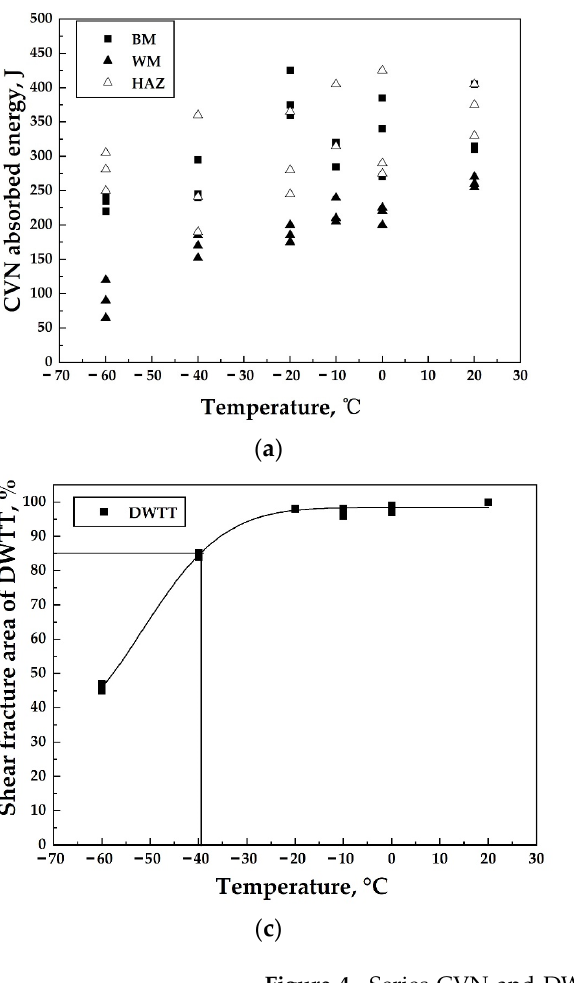
TEM micrographs illustrating the microstructure of BM are presented in Figure 5. The microstructure consisted of polygonal ferrite (PF) plus lath bainite. PF microstructure with mobile dislocations induced by the shear process and volume expansion caused by the transformation from austenite to bainite (Figure 5a), guaranteeing the excellent deformability. Lath bainite contained high density tangled dislocations and substructures (Figure 5b), leading to the high